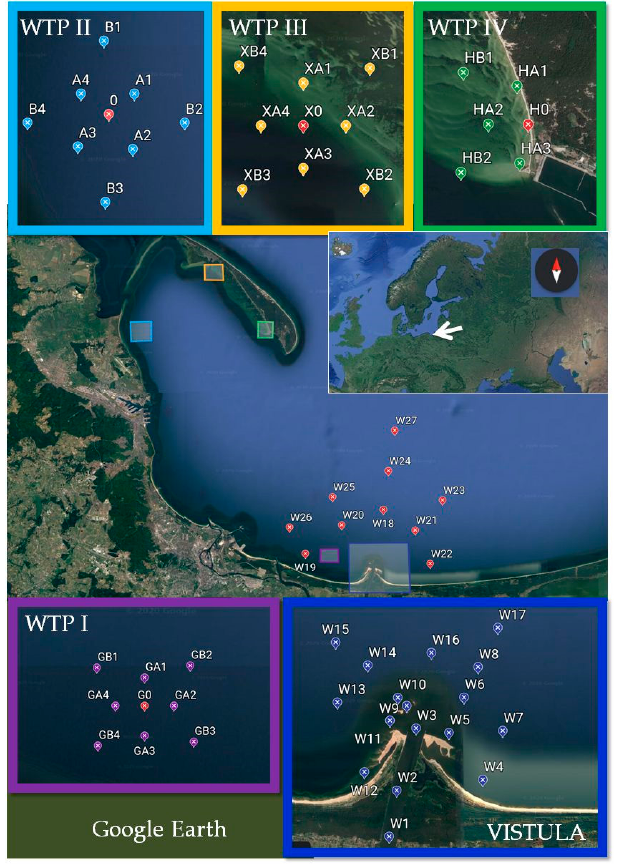
Figure 6. Sampling sites of sediments in the area the Gulf of Gdansk (WTP I–IV-wastewater treat- ment plant).